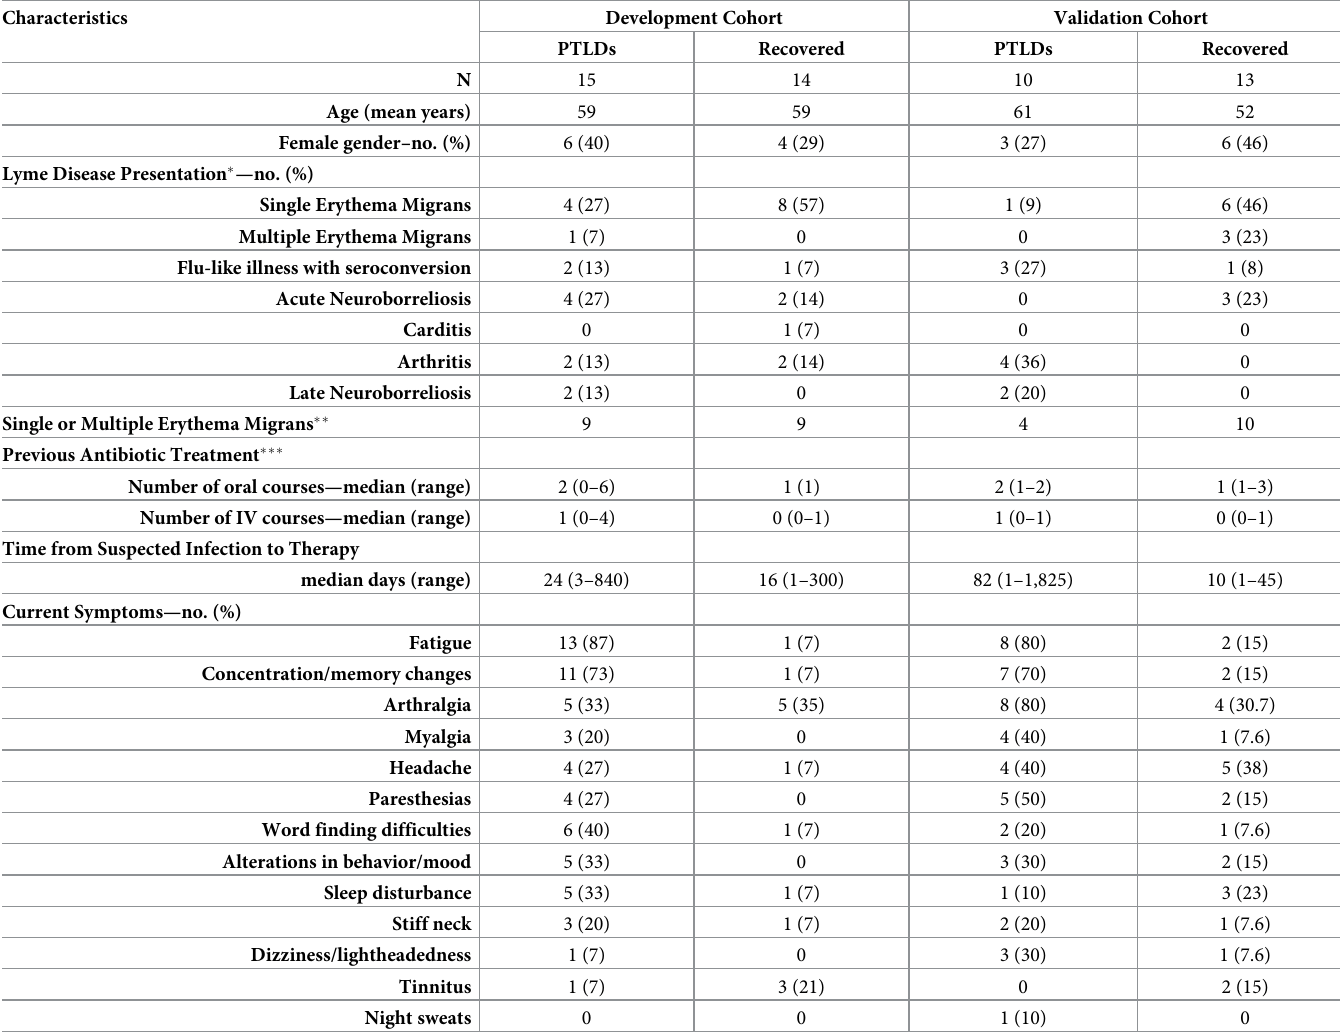
Table 1. Study participant